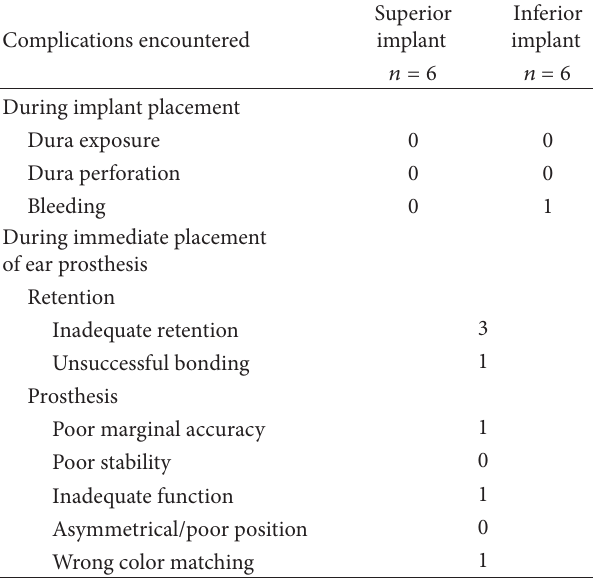
Table 1: Intra-operative complications encountered.